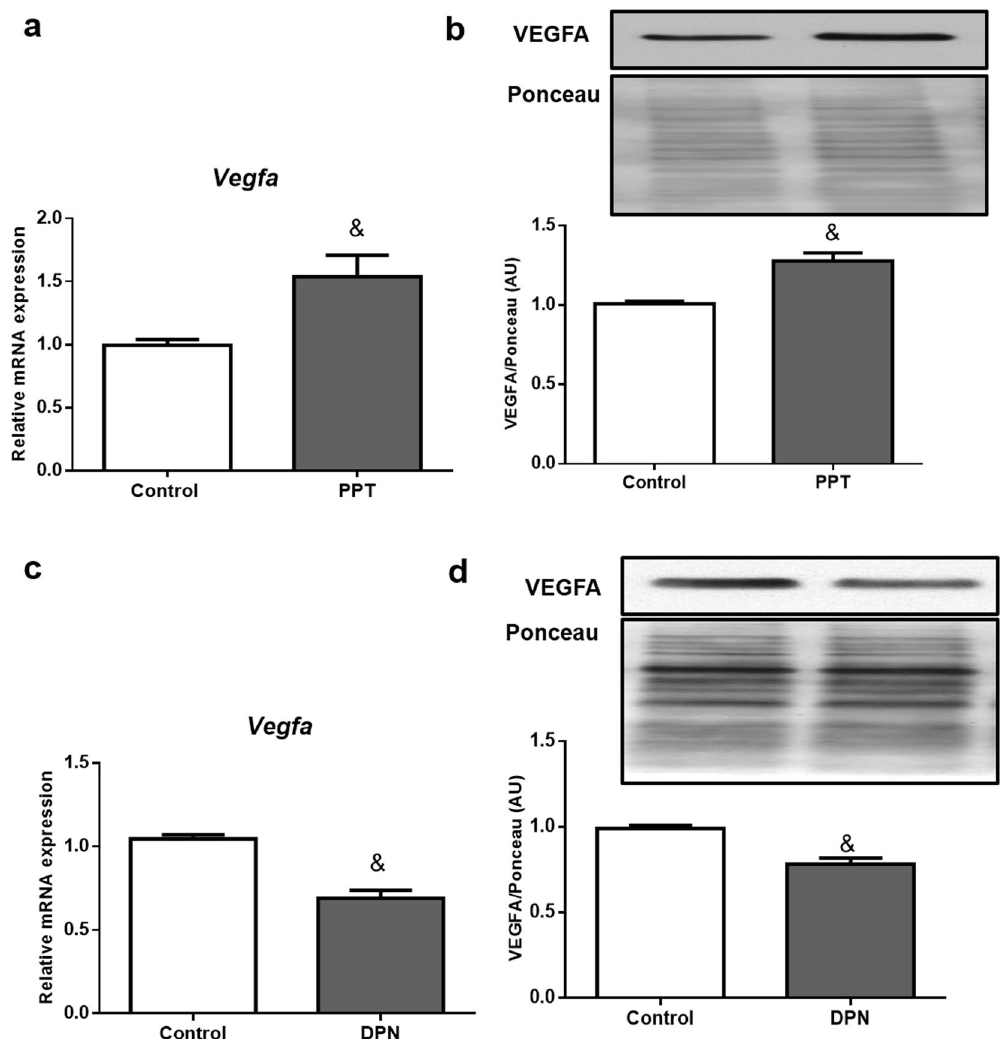
Figure 3. Effects of ESR1 agonist (PPT) and ESR2 agonist (DPN) on VEGFA mRNA and protein: 3T3-L1 adipocytes were treated for 24 hours with 10 nM of PPT ( a , b ) or 10 µ mol/L of DPN ( c , d ). Full-length blots of these cropped images are presented in Supplementary Figure S1. Cells treated with vehicle (0.1% DMSO) were used as control. The representative autoradiograms are shown on top. Data are shown as the mean ± SEM of 6 samples. & P < 0.05 vs